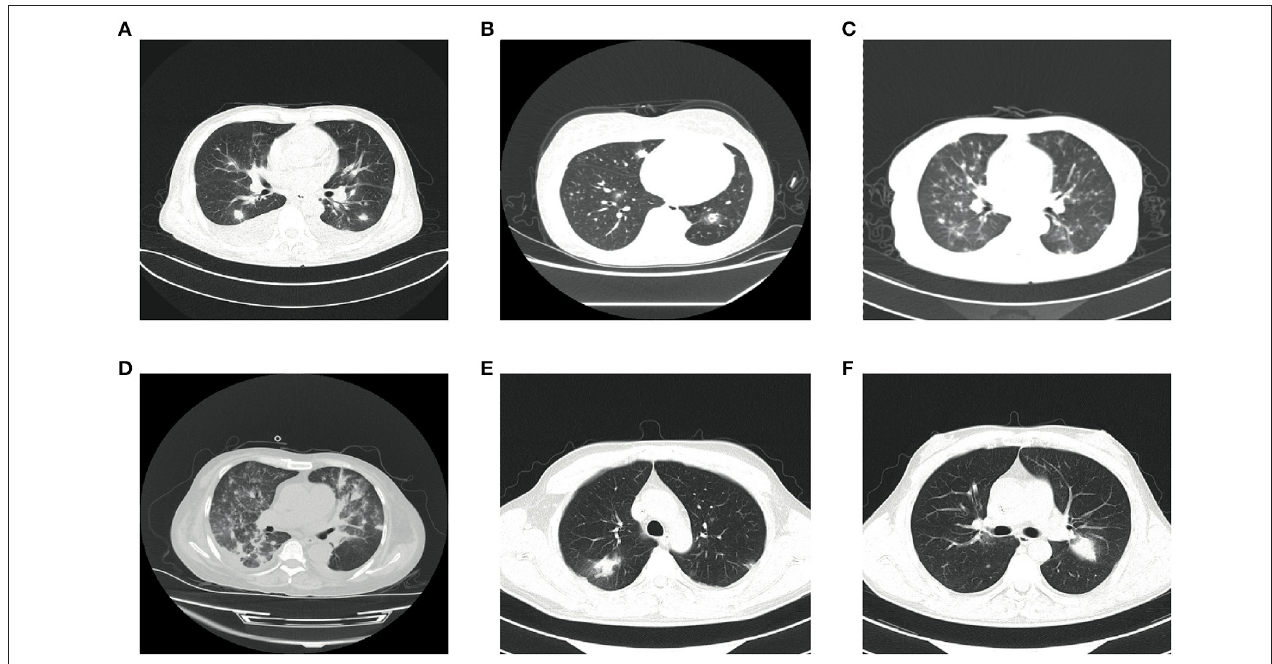
FIGURE 2 | Findings of chest CT scan. (A) Chest CT of case 1 showing multiple small nodules in both lungs and a little pleural effusion on both sides. (B) Chest CT of case 2 showing multiple small nodules in both lungs and halo signs around some nodules. (C) Chest CT of case 3 showing multiple small nodules along the vascular bundles in both lungs and a little pleural effusion on both sides. (D) Chest CT of case 4 showing multiple irregular nodules in both lungs and a little pleural effusion on the right side. (E,F) Chest CT of case 5 showing multiple nodules and masses in both lungs.